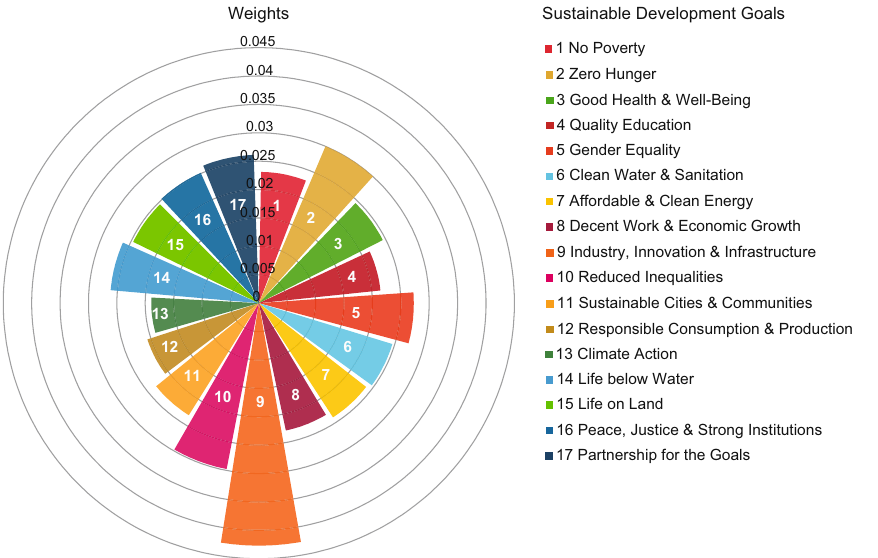
Figure 3. The SDGs-GENEPY weights of the Sustainable Development Goals. The radial bar chart plots the SDGs-GENEPY weights Y g / k ′ g for all Goals (see “Results” section, Eqs. (4), and “Materials and methods” section). Conversely from the original SDGs circle (in which all Goals are equally distributed on a doughnut plot 11 ), the present radial bar plot remarks that–although Goals are all equal in principle–there exists a difference of importance according to the proposed data-based approach. The figure has been generated using Excel